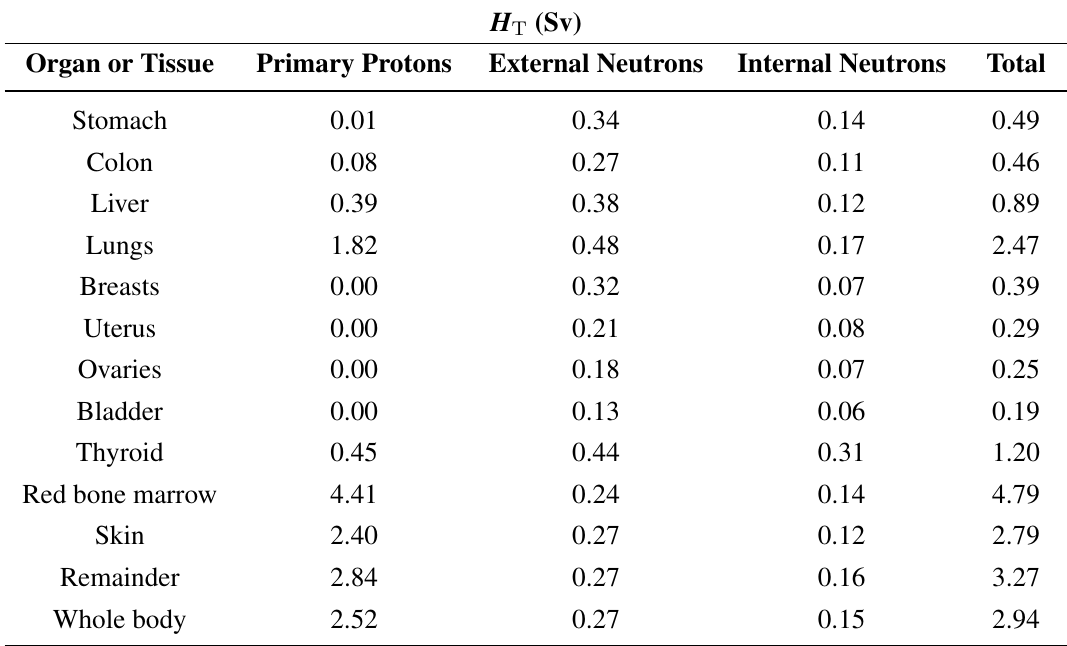
Table 4. Mean organ equivalent dose, H Anderson. The values in the table include H generated in the treatment unit (“external neutrons”), and neutrons generated in the patient (“internal neutrons”). The TPS does not estimate statistical uncertainty in dose, and the statistical uncertainties for neutron H